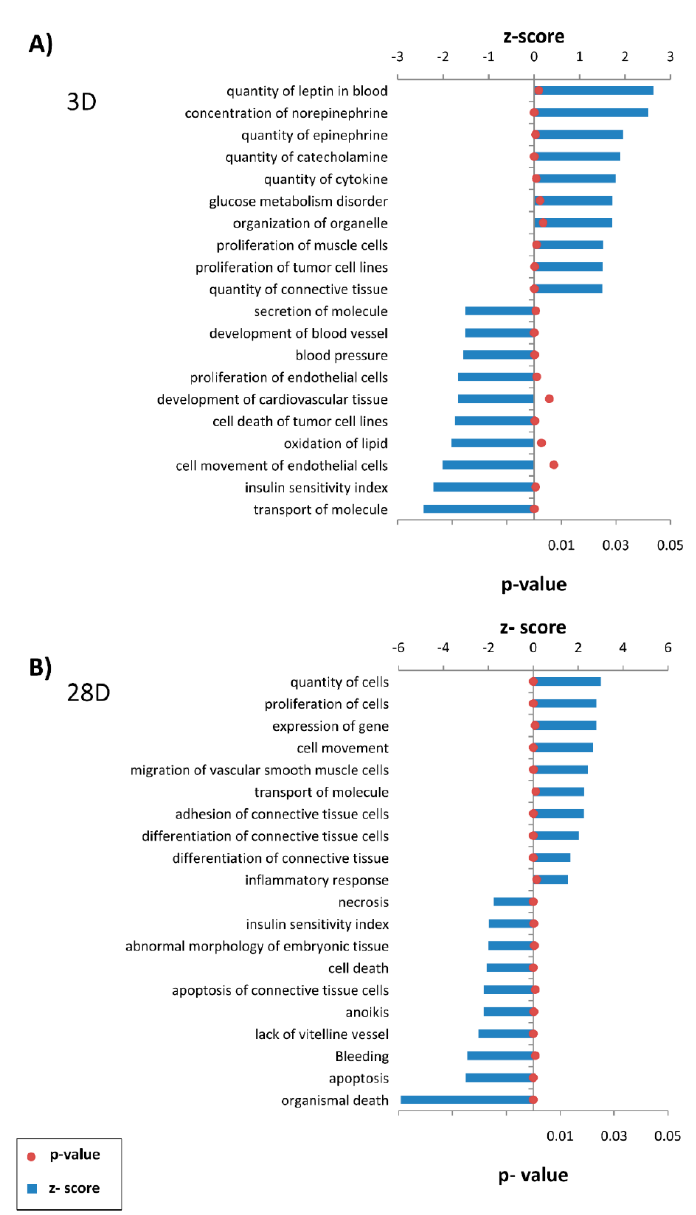
Figure 4. Disease and functional analysis using the IPA knowledgebase for ( A ) 3 days and ( B ) 28 days after the onset of venous arterialization compared with the normal jugular vein. The bars represent z-scores, and the points represent the p -value for each disease and function annotated. Diseases and functions with z-scores > 1.5 or z-scores < 1.5 and p -value < 0.01 were selected. The complete list is available in Tables S1 and S2.